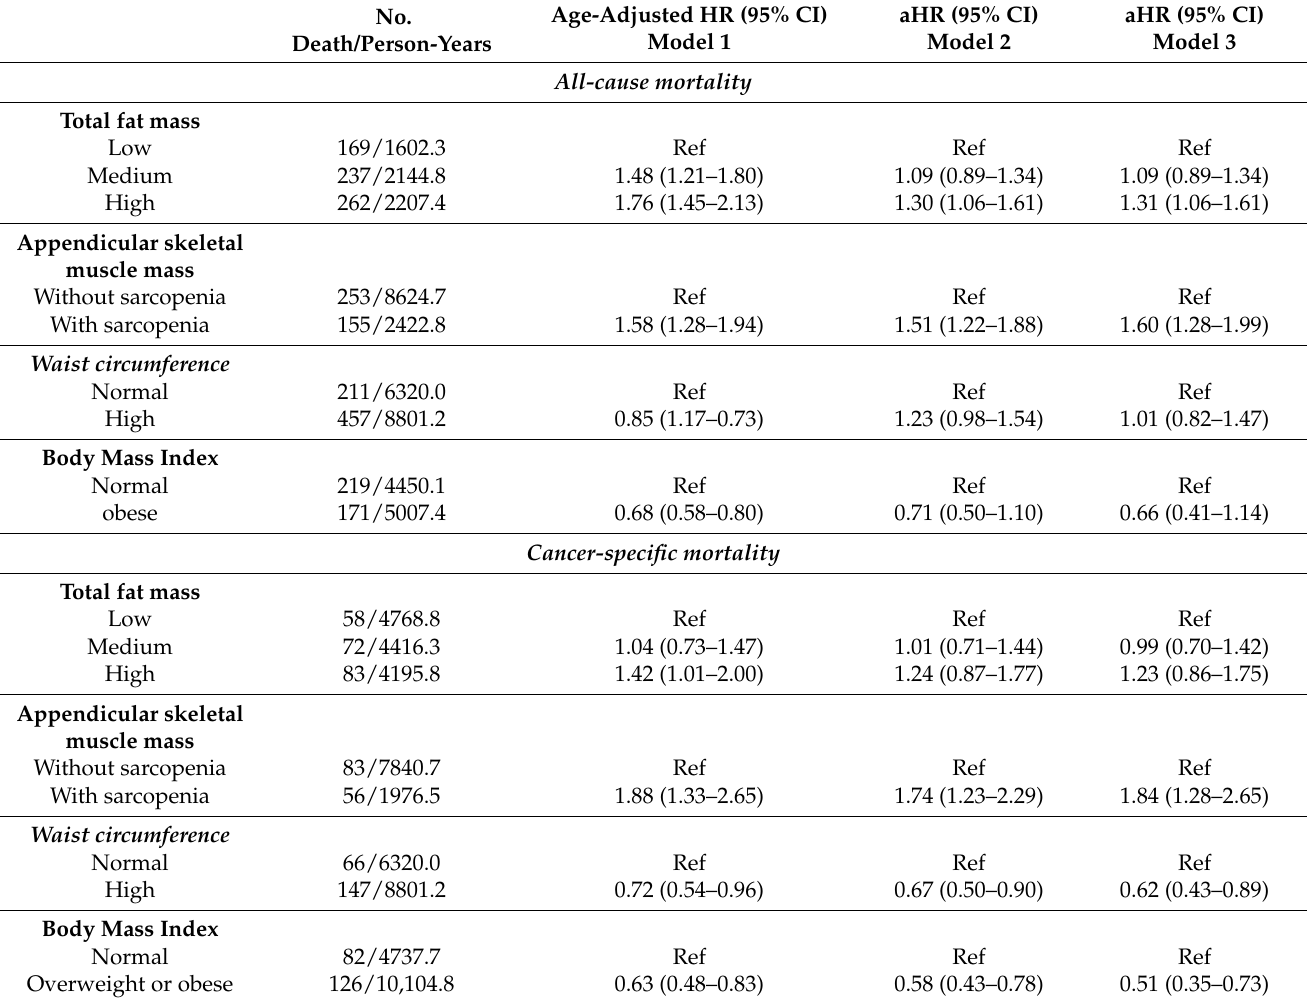
Table 2. Association between DXA measures of body composition and risk of all-cause and cancer- specific mortality in cancer